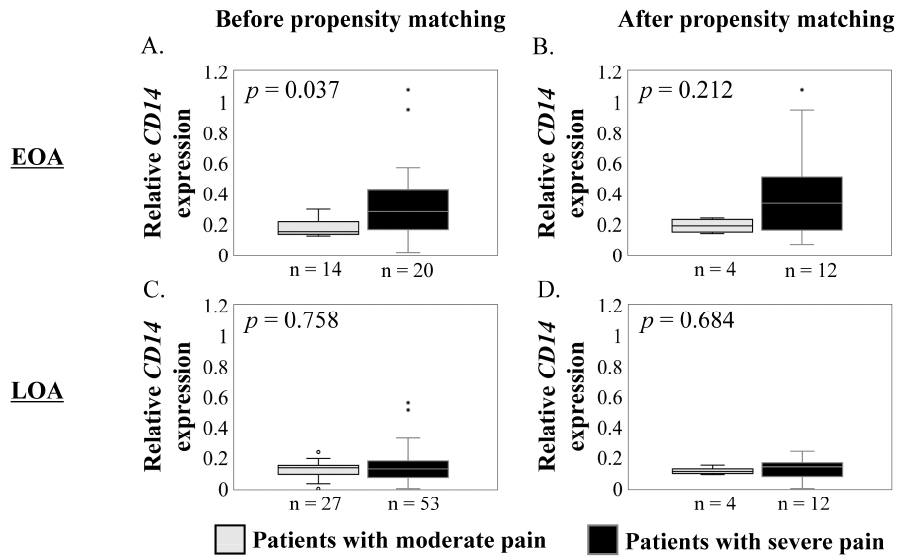
Figure 2. Comparisons of synovial CD14 expression between moderate and severe pain in patients with early hip osteoarthritis (EOA) and late hip osteoarthritis (LOA). Synovial CD14 expression ( y axis) in EOA patients with moderate (gray boxes) and severe (black boxes) pain before ( A ) and after ( B ) propensity matching. Synovial CD14 expression in LOA patients with moderate and severe pain before ( C ) and after ( D ) propensity matching. Boxes represent median and IQR (interquartile range, 25–75th percentiles); whiskers represent range within 1.5 × IQR; and small circle represent values outside 1.5 × IQR. Y axis, relative CD14 mRNA expression. The Mann–Whitney U -test was used for analysis. p < 0.05 indicates statistical significance.